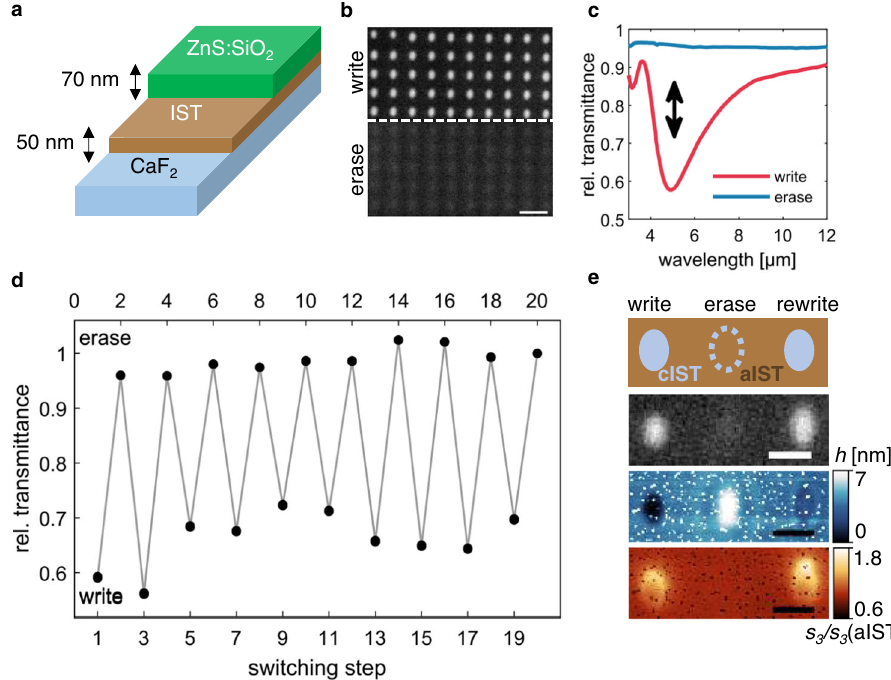
Fig. 2 Write and erase. a Sketch of the sample layer stack. b Light micrograph (scale bar 3 µ m) of a cIST nanoantenna array written (top) and erased (bottom) by optical switching. c FTIR transmittance measurements of the written and erased arrays from b . d Relative transmittance at 4.66 µ m (resonance minimum) for 20 switching steps. e Sketch, light microscope, AFM (height h ) and s-SNOM ( λ = 10.57 µ m, see Methods) images of written, erased and rewritten nanoantennas (scale bar is 1 µ